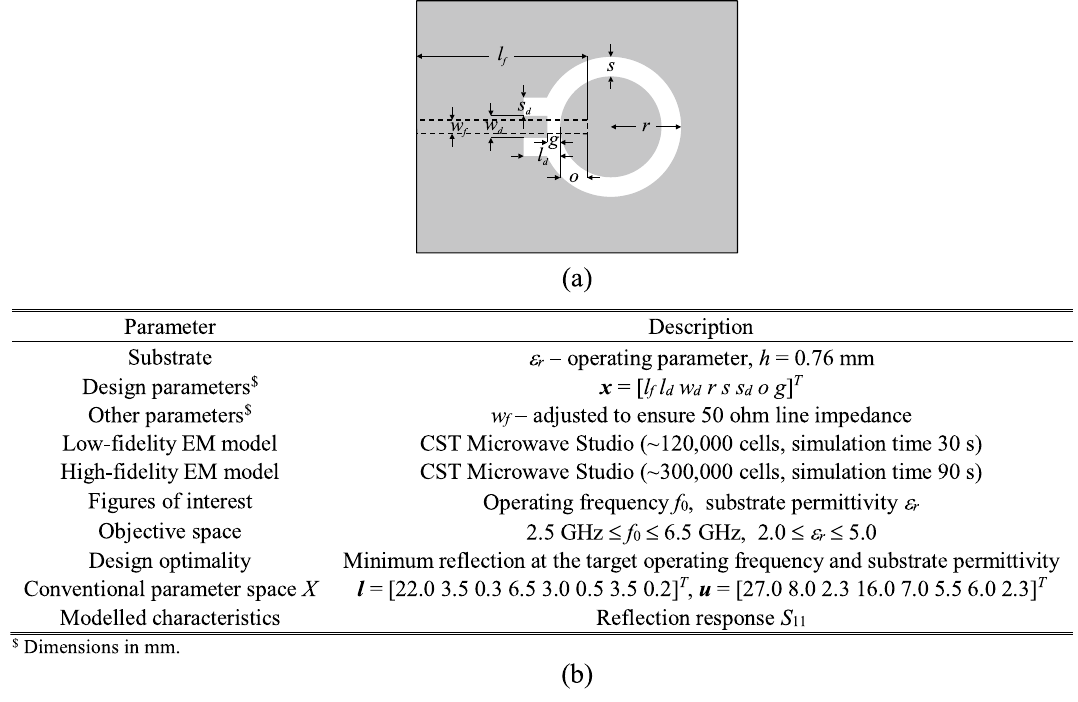
Figure 8. Antenna I: ring-slot microstrip antenna: ( a ) antenna geometry, ( b ) antenna